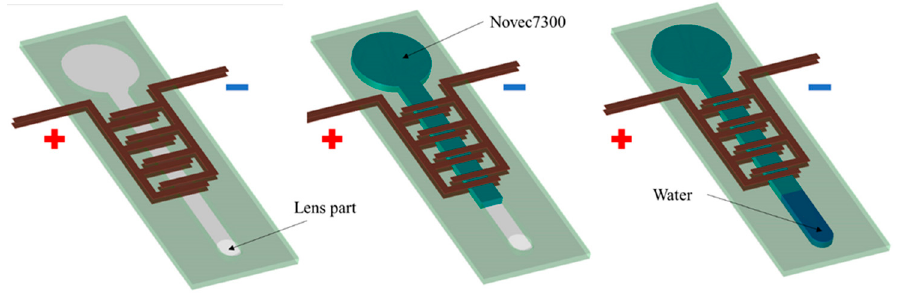
Figure 5. Experimental setup of focus-tunable lens driven by EHD pump.